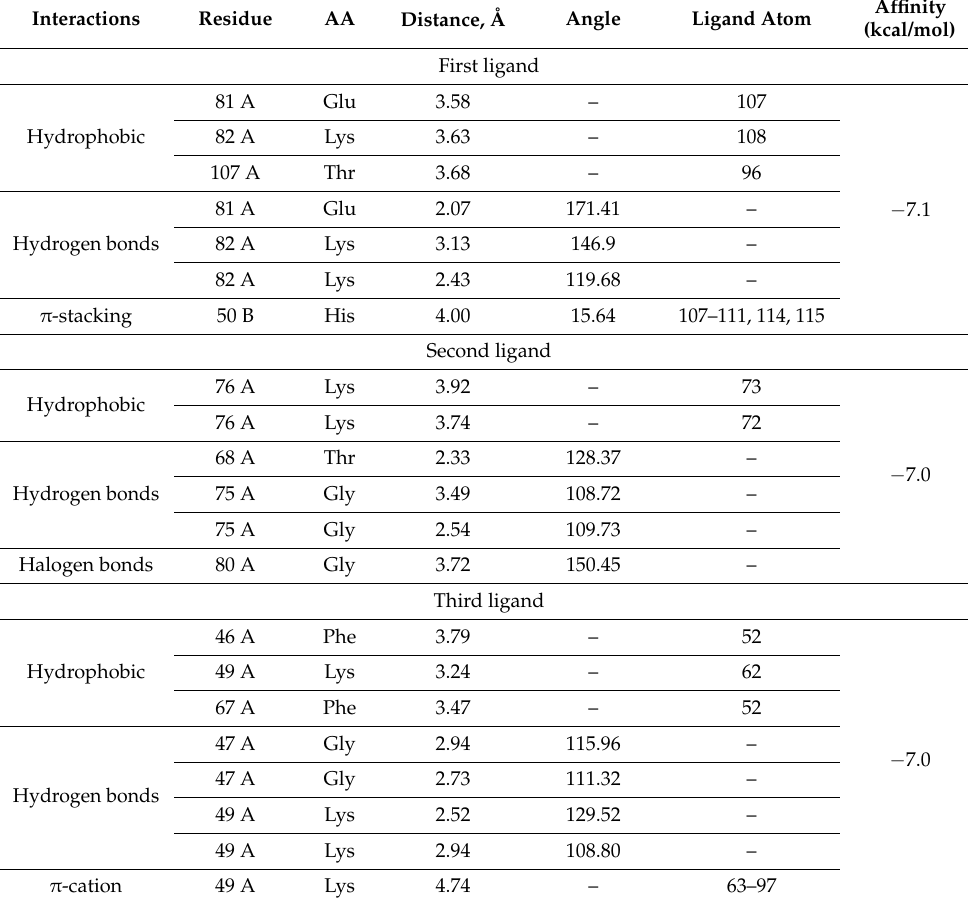
107 A Thr 3.68 – 96 Hydrogen